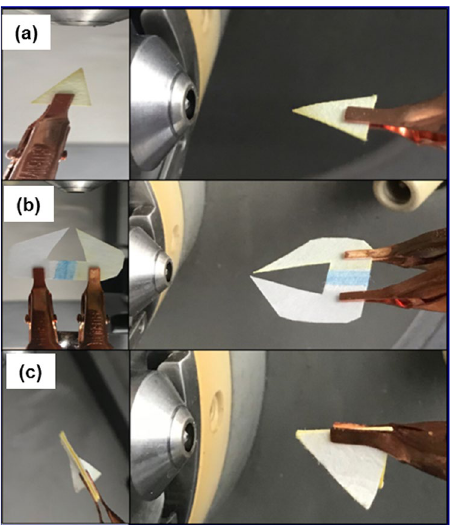
Figure 1. Photograph of the three PS arrangements: ( a ) single tip, ( b ) dual-tip, and ( c )